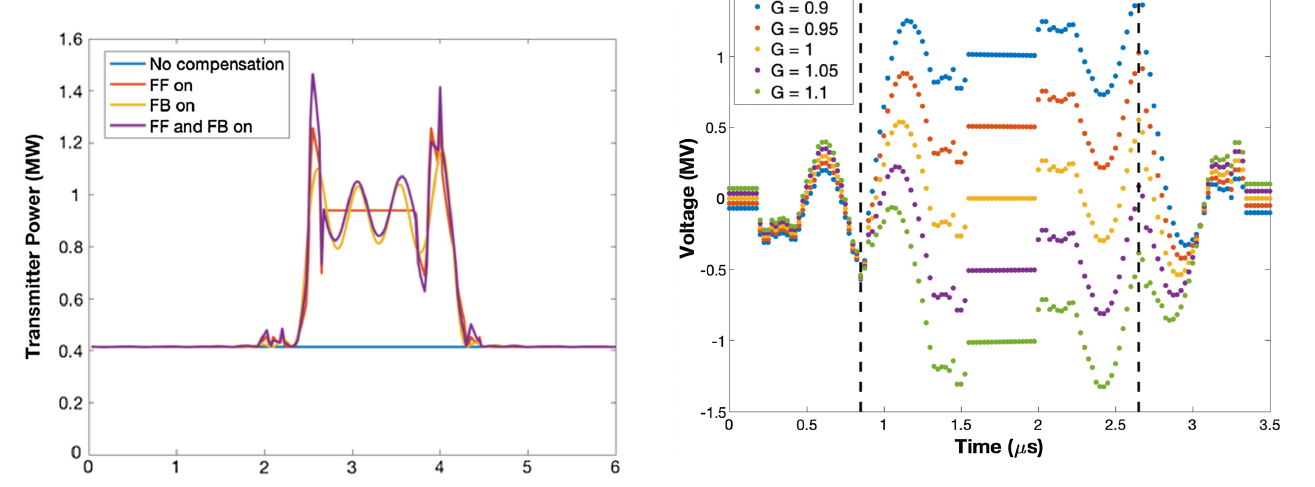
FIG. 10. Uncompensated beam loading with nonideal feedfor- ward gain (feedback off). Vertical markers indicate the extent of the